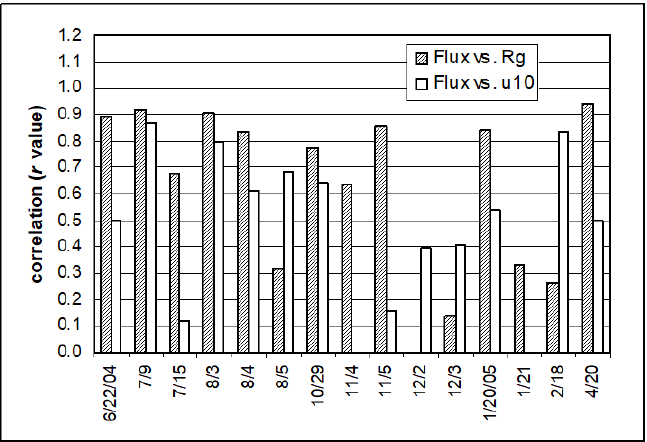
Figure 4. Correlations of the Hg air / water exchange fluxes at Cane Creek Lake (TN, USA) with solar radiation ( R g ) and wind speed ( u 10 ) for each of the 15 sampling days from June to April (the negative correlation values are not shown).